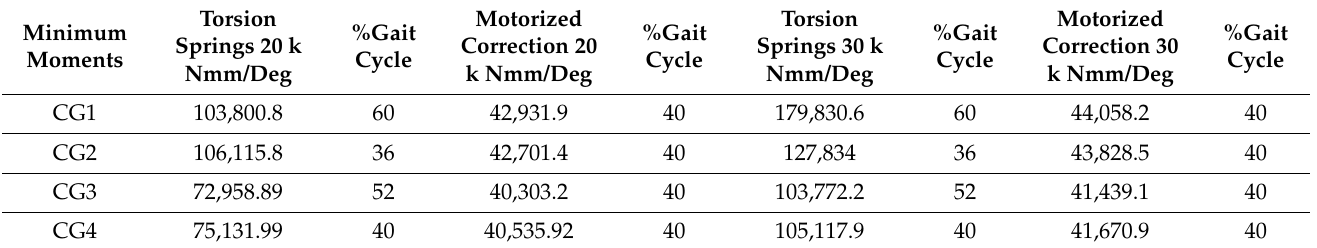
Table 4. Moment minima taken from simulations for each crouch gait.